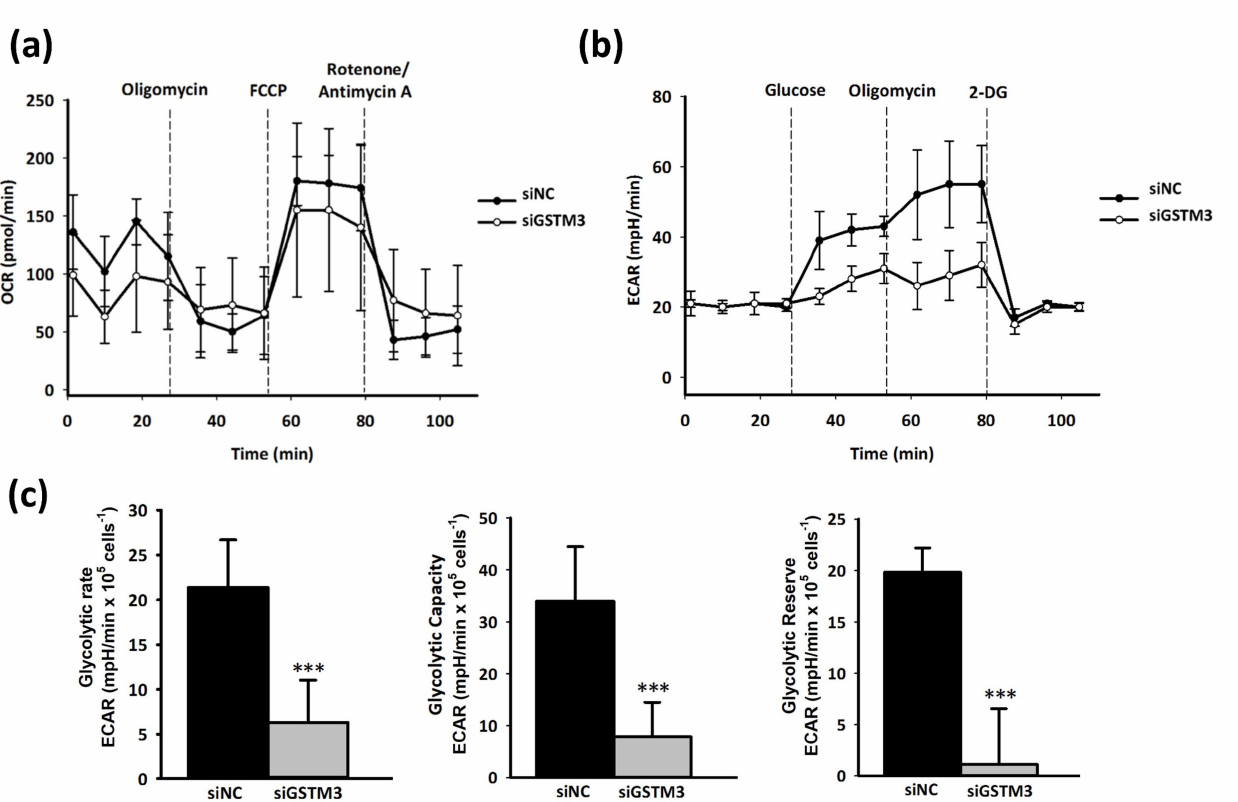
Figure 5. OCR and ECAR values from a glycolysis stress test in GSTM3-knockdown T98G cells. T98G cells treated with siRNA knockdown were depleted 72 h after transfection. The ECAR was measured and normalized to cell number by using the Seahorse XF Analyzer in cells. ( a ) Real-time measurement of the OCR as mitochondrial respiration. Oligomycin (1 µ M), FCCP (0.5 µ M), and rotenone/antimycin A (0.5 µ M) were injected at the indicated times. Values are expressed as mean ± SD ( n = 3). ( b ) Real-time measurement of the ECAR as the glycolysis rate. Glucose (10 mM), oligomycin (1 µ M), and 2-DG (50 mM) were injected at the indicated times. Values are expressed as mean ± SD ( n = 3). ( c ) The glycolytic rate, glycolytic capacity, and glycolytic reserve were analyzed using standard methods. Values are expressed as the mean ± SD ( n = 3). *** p < 0.001 relative to